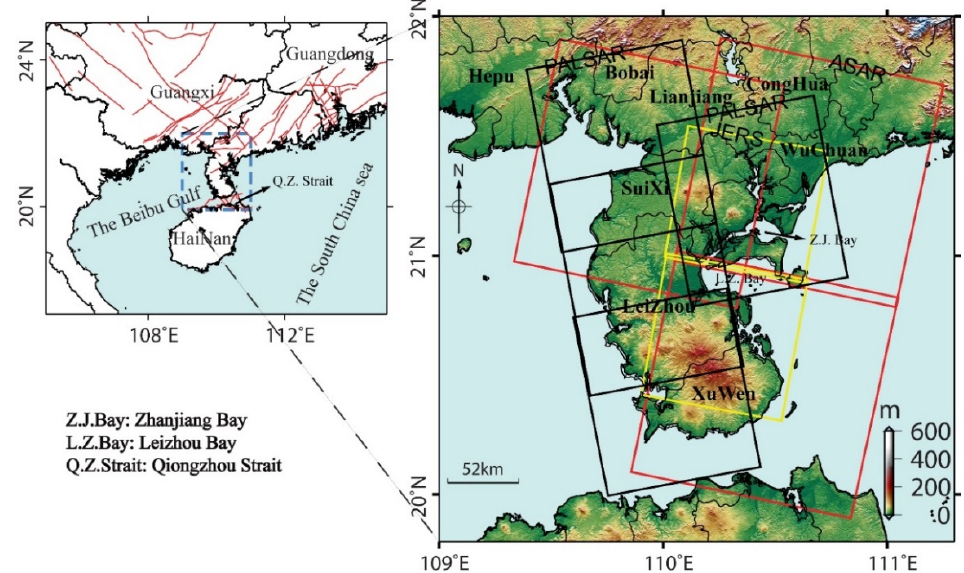
Figure 1. Background setting (left) and Synthetic Aperture Radar (SAR) coverages (right) of the Leizhou Peninsula. The yellow, red, and black rectangles represent the coverage of JERS, ENVISAT, and ALOS1 respectively.